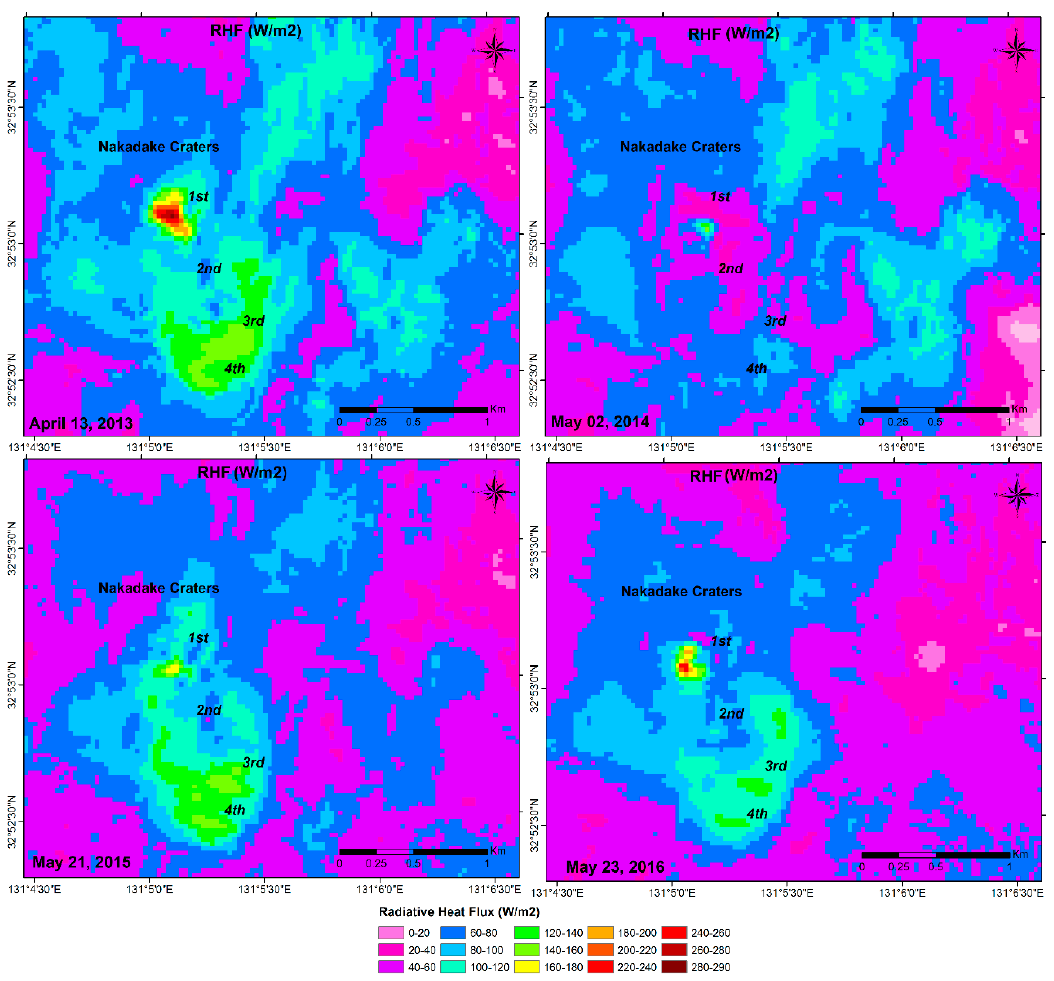
Figure 6. Radiative heat loss of the study area, showing pixel-based spatial RHF. Nakadake craters shown in the maps using consecutive numbers.